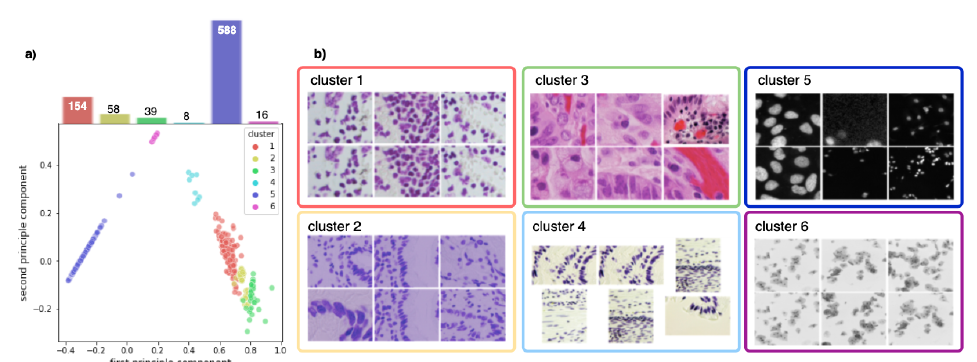
Figure 2. ( a ) PCA decomposition of hue saturation values of all training images and their class distribution. Each point represents one image, colored according to the corresponding cluster. ( b ) Exemplary images for each